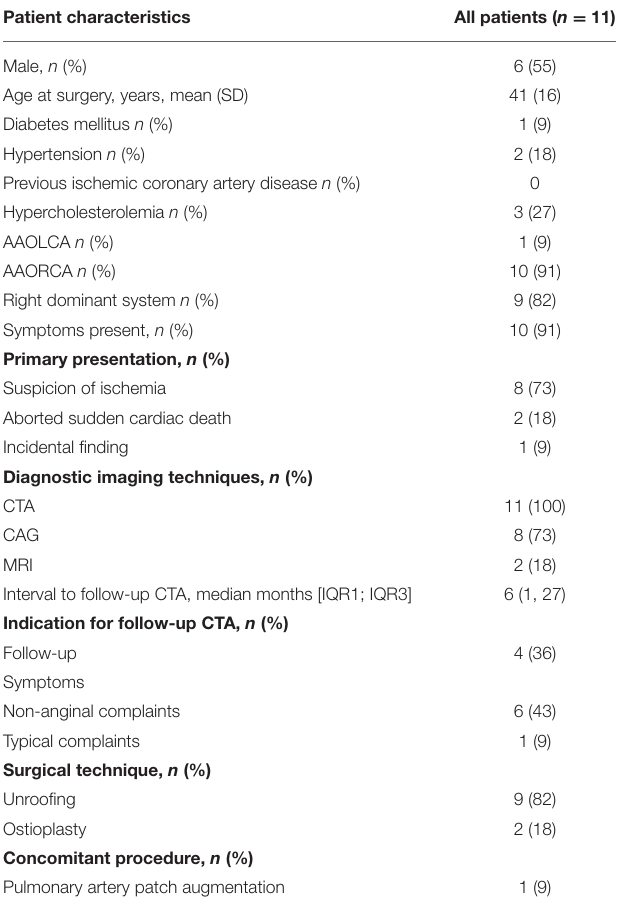
TABLE 1 | Baseline characteristics of the patient cohort described in this study. Patient